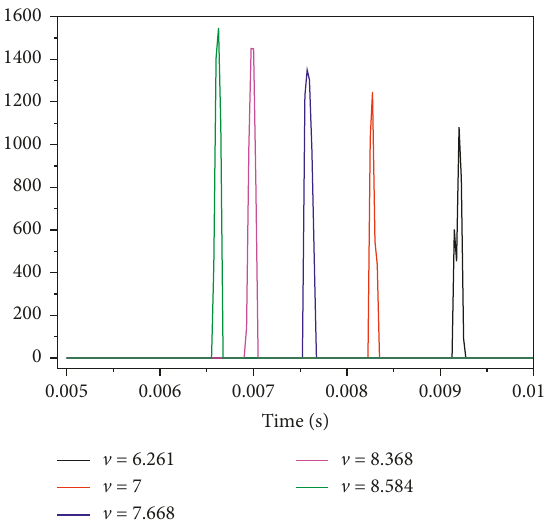
Figure 17: Contact